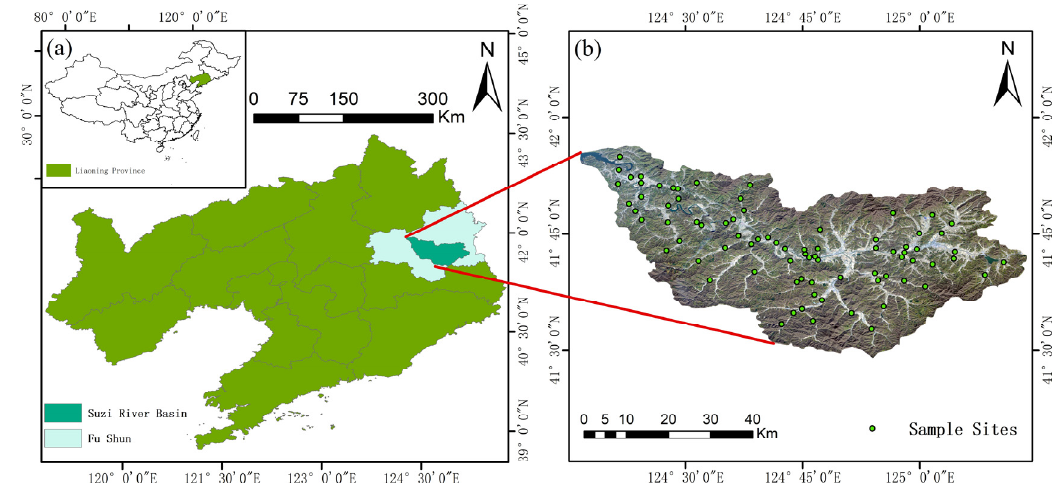
Figure 1. ( a ) The location of study area (Suzi river basin) in Liaoning Province and the position of Liaoning Province in China, and ( b ) the position of sampling sites (80) in study area with Landsat 8 OLI image after true color compositing by bands 4 (red), 3 (green), and 2 (blue).